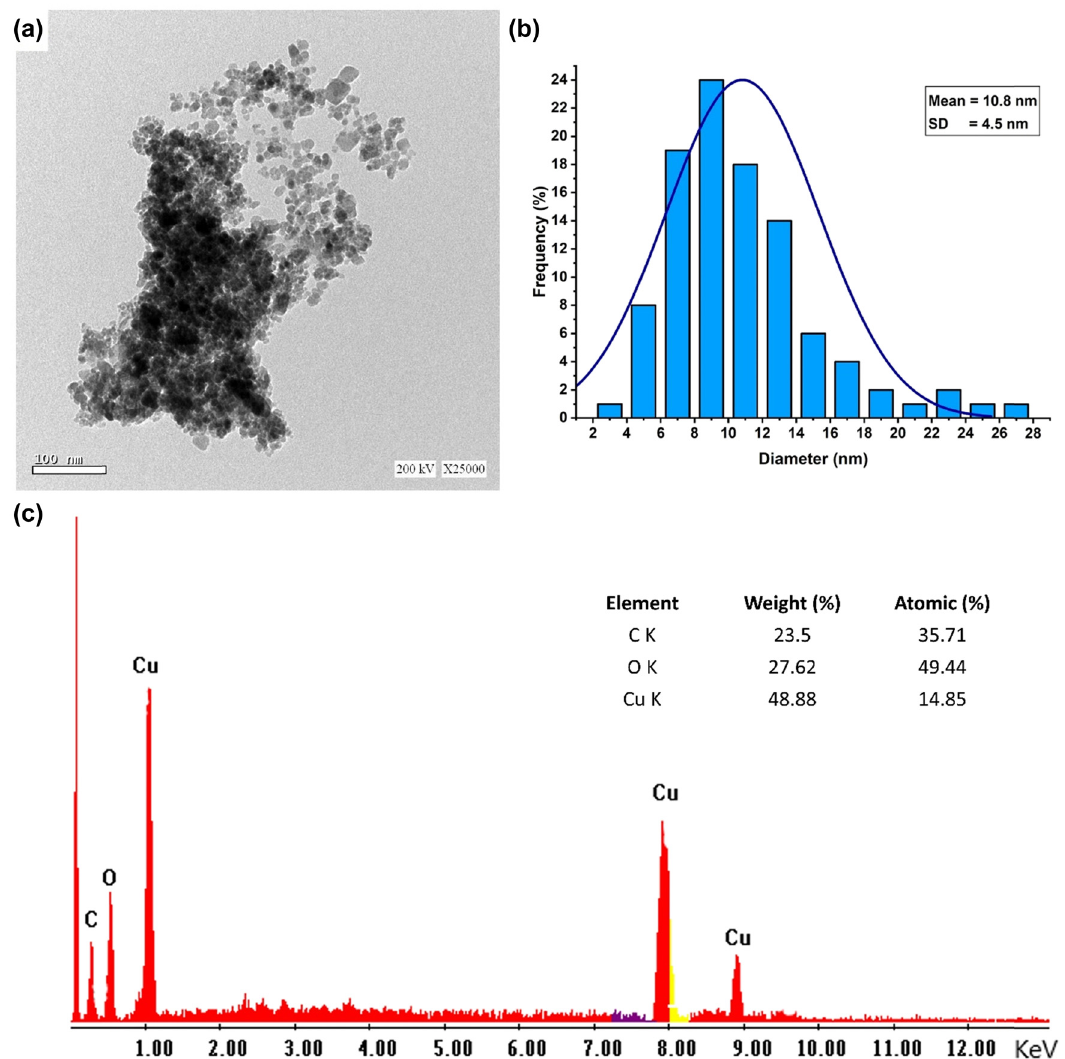
Figure 2: Characterization of CuO - NPs synthesized by endophytic bacterial strain, B. brevis . ( a ) TEM analysis showed spherical shape, ( b ) size distribution of synthesized CuO - NPs showed average particle size of 10.8 ± 4.5 nm, and ( c ) EDX chart showing the sample containing Cu, O, and